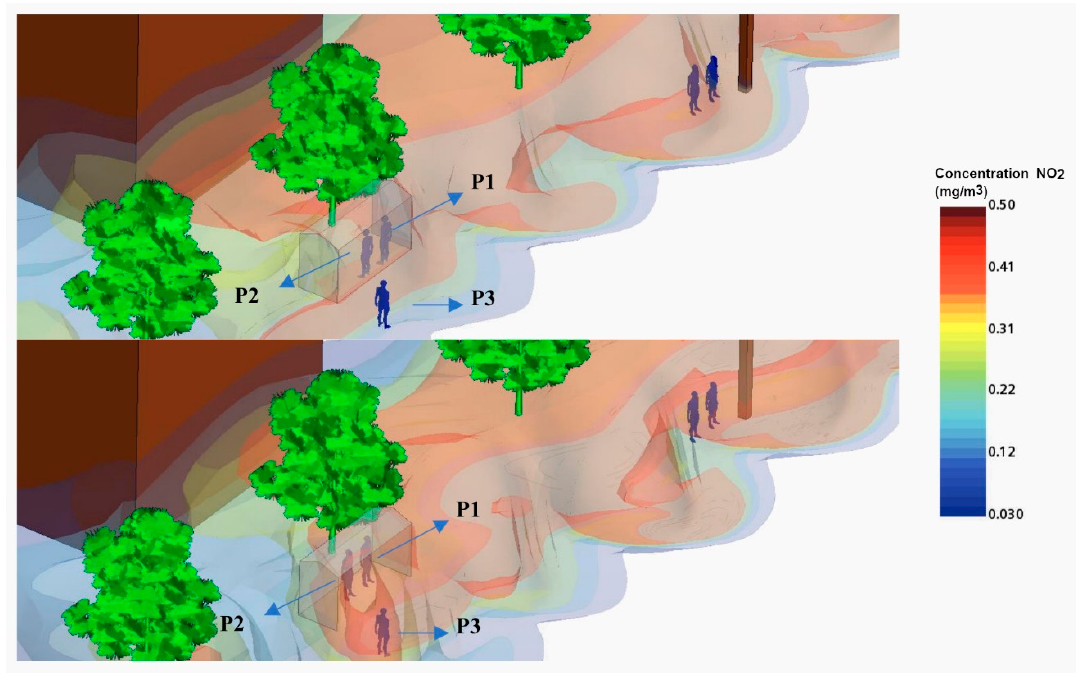
Figure 10. Illustration of NO 2 gas dispersion for the FA and FT orientation of a generic bus stop shelter, located 15 m downstream of the traffic light.